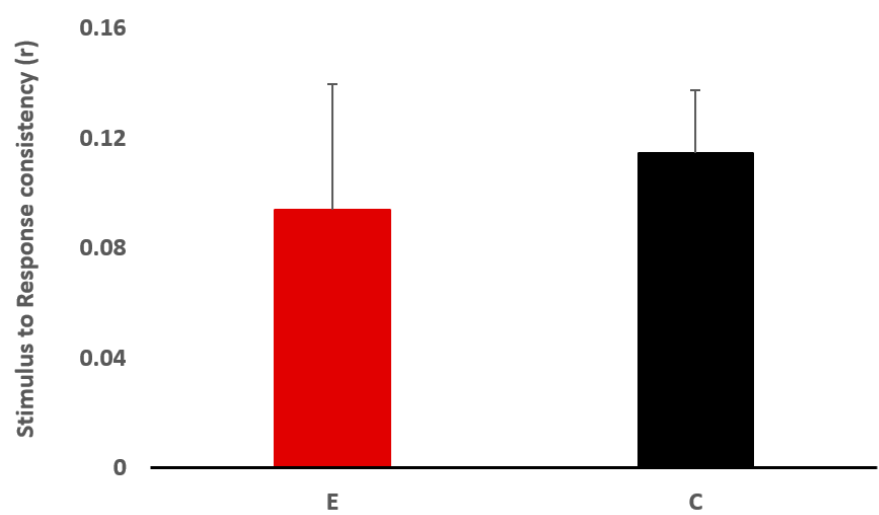
Figure 3. Stimulus to Response consistency (r) for the experimental (E) and the control (C)